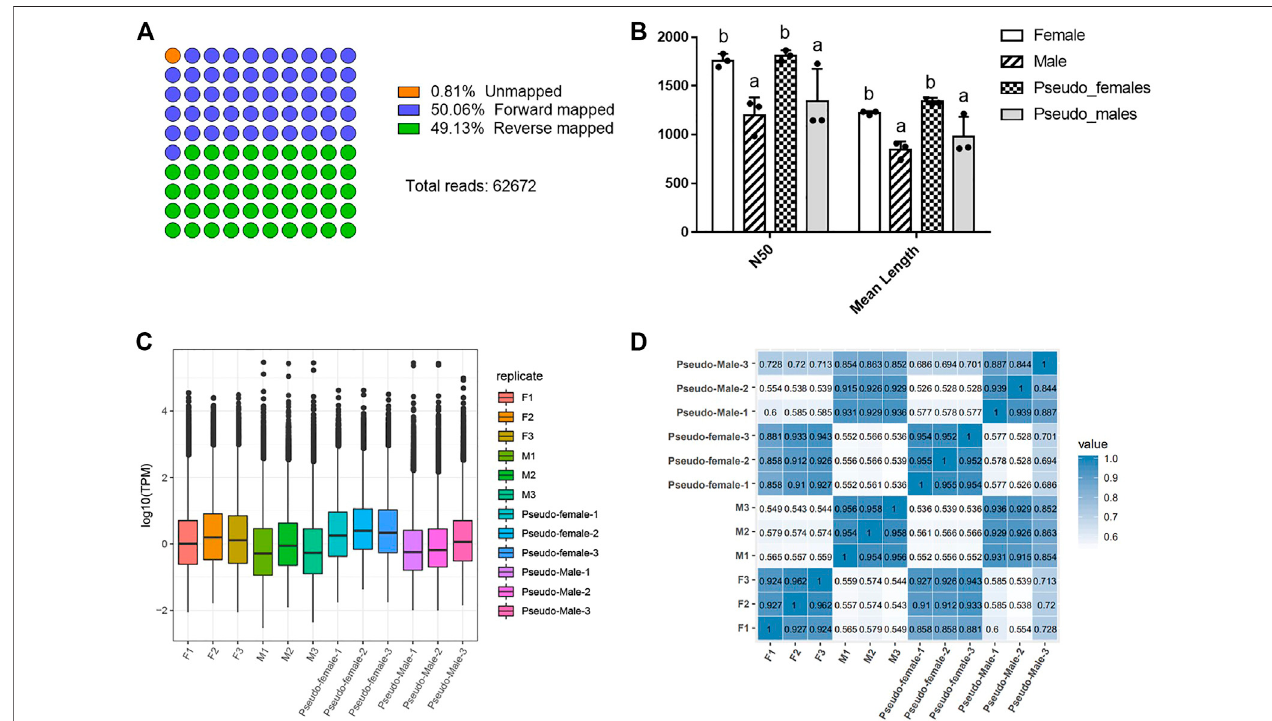
FIGURE1| StatisticsofdirectRNAsequencingdataofdifferentsamples. (A) Themappeddiagramofsequencingdata. (B) ThehistogramofthedistributionofN50 and meanlength.Datawereexpressed asmean±SD.Differentsuperscriptsindicatesigni fi cantdifference ( p < 0.05). (C) TheTPMboxplotofdifferentsamples. (D) The correlation analysis on the different samples. F1: Female-1, F2: Female-2, F3: Female-3, M1: Male-1, M2: Male-2, M3: Male-3, PF1: Pseudo-female-1, PF2: Pseudo- female-2, PF3: Pseudo-female-3, PM1: Pseudo-male-1, PM2: Pseudo-male-2, PM3: